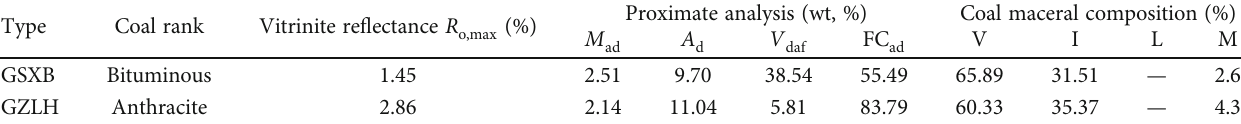
Table 1: Raw coal properties.